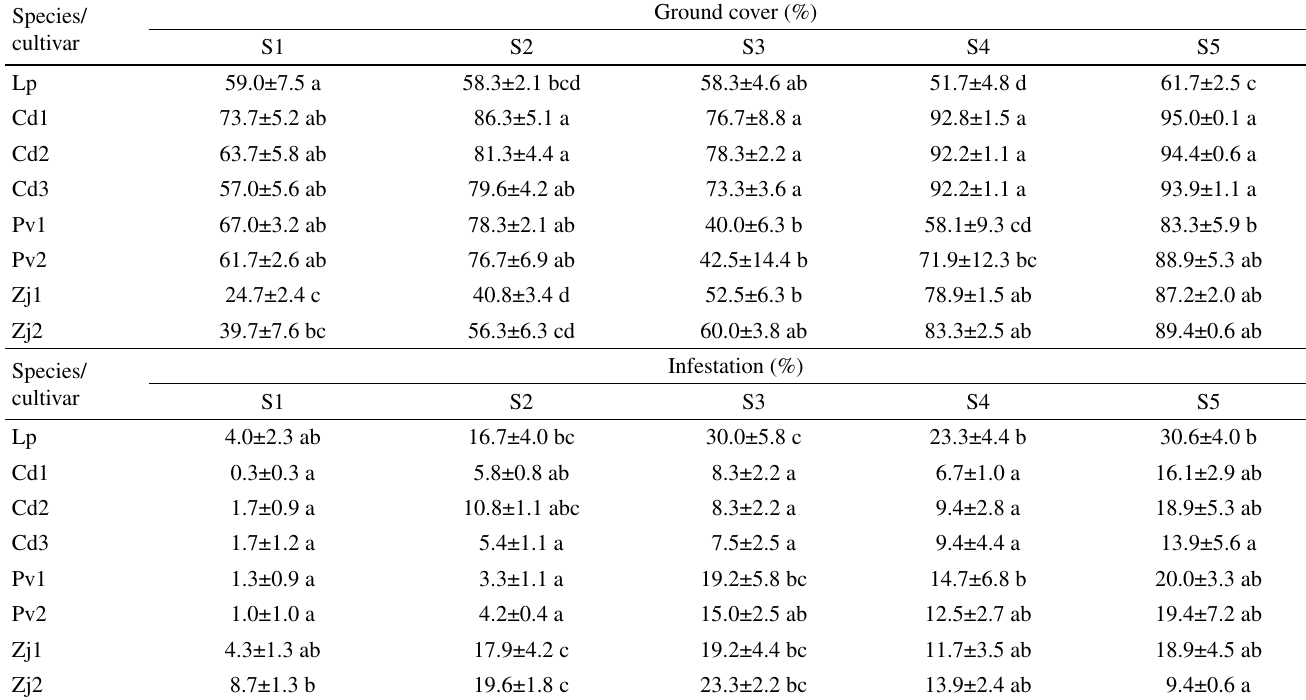
Table 1 - Average value (±SE) of ground cover and infestation of the tested cultivars over the 5 seasons Species/